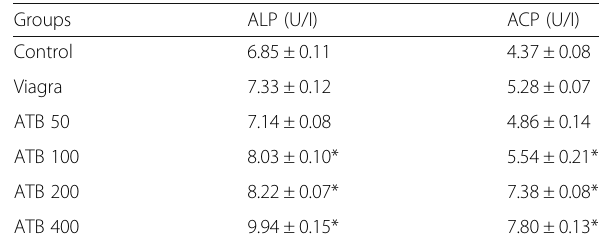
Table 2 Effect of ATB on penile reflexes in treated male rats Parameter